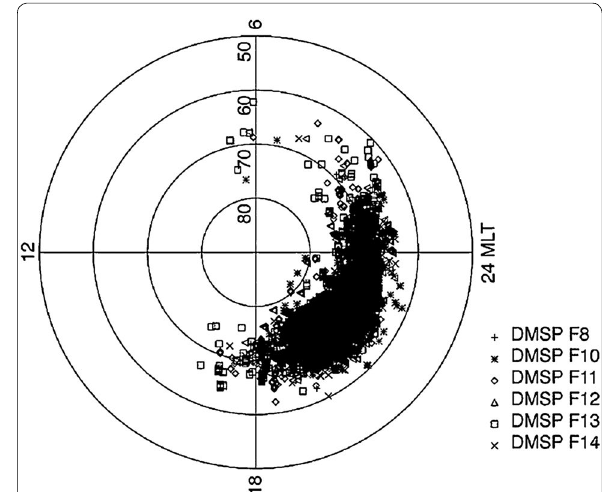
Fig. 8 Distribution of local time of LEO DMSP satellite anomalies (Anderson